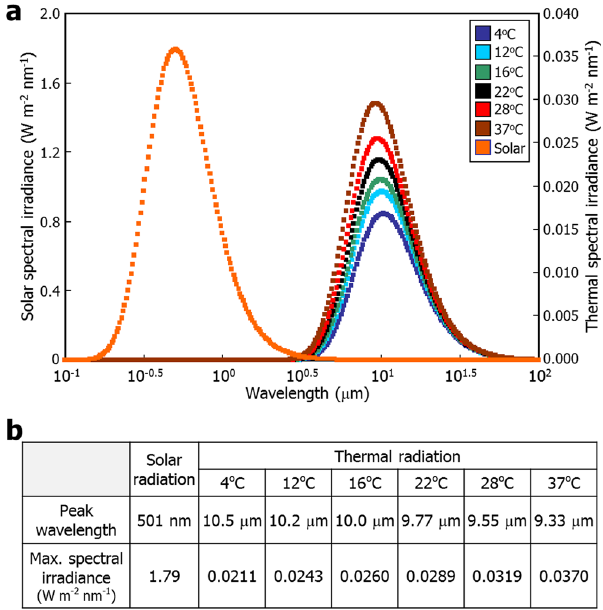
Figure 1. Spectral analysis of plant environmental temperatures. ( a ) Calculation of thermal spectral irradiance. Spectral irradiance of plant environmental temperatures in a range of 4 °C to 37 °C was calculated according to the Planck’s law of blackbody radiation. Solar radiation was included in the analysis for comparison. The calculation values were plotted against wavelength. The X-axis is represented in a logarithmic scale. ( b ) Peak wavelength of spectral irradiance. The peak wavelength and maximal spectral irradiance values were obtained from the spectral calculations in ( a